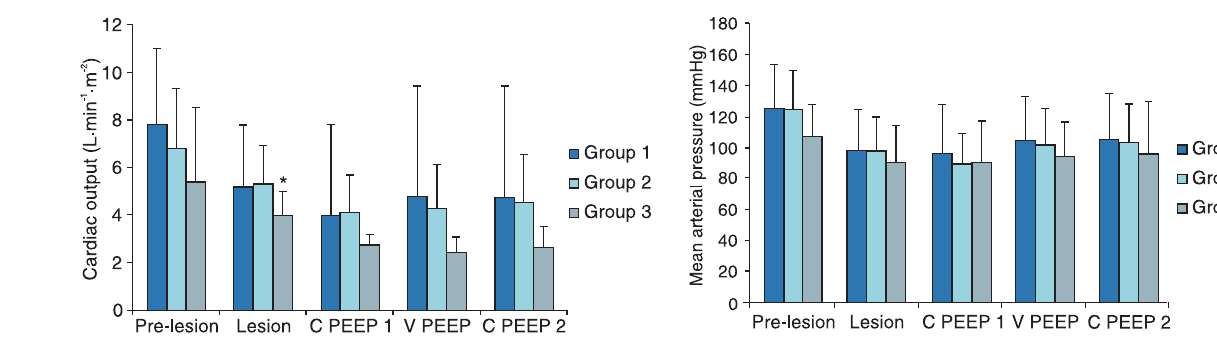
Figure 2. Cardiac output is reported as means ± SD for all groups. See Figure 1 for explanation of abbreviations. *P < 0.05 vs C PEEP 1, V PEEP and C PEEP 2 (Tukey-Kramer test).